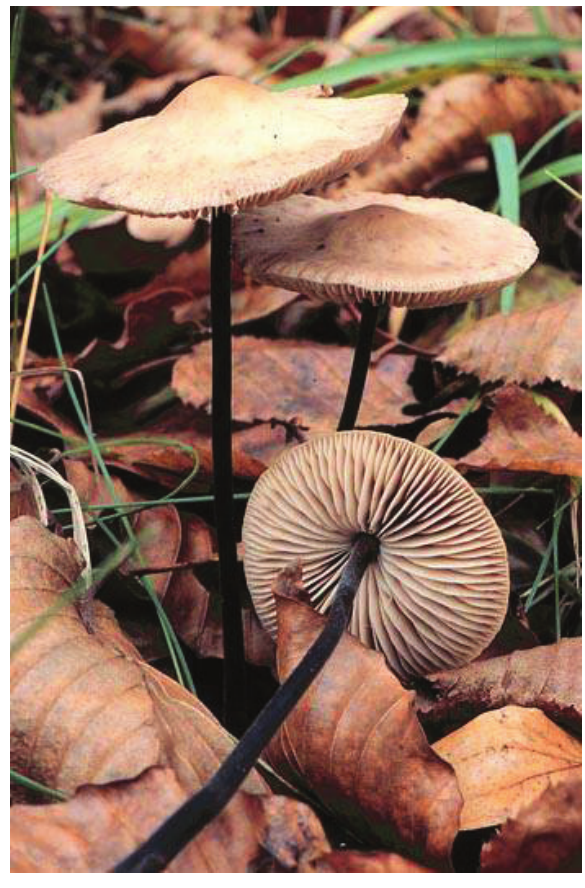
Figure 3. Mycetinis alliaceus . Habit photo. Standard bar = 10 mm. Courtesy